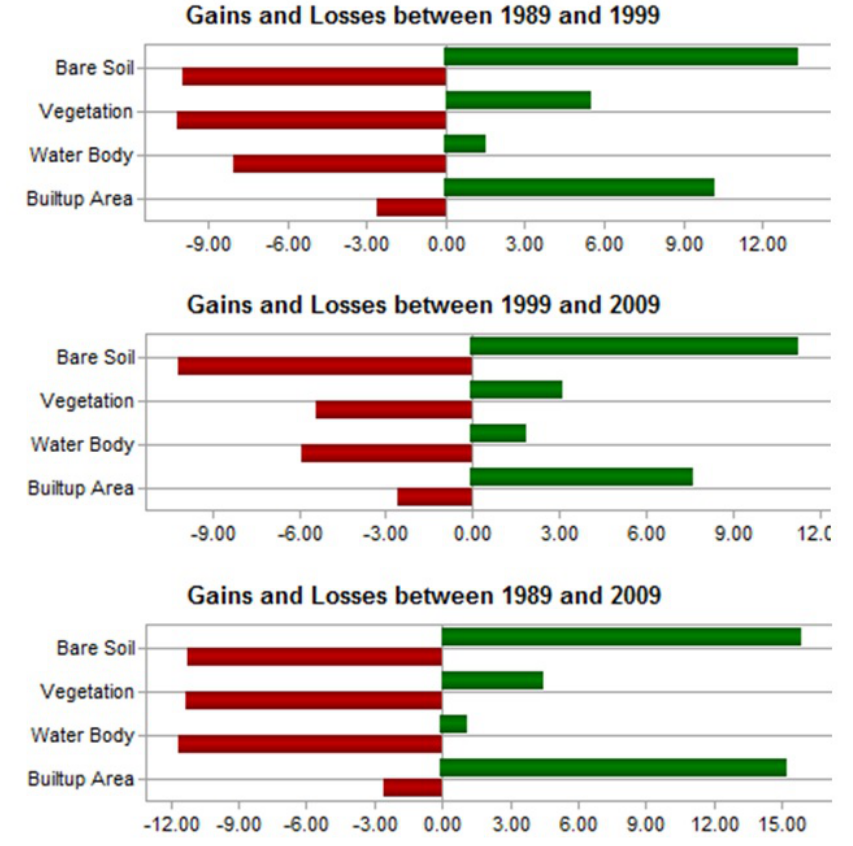
Figure 7. Gains and losses of the land cover types (Unit: % of